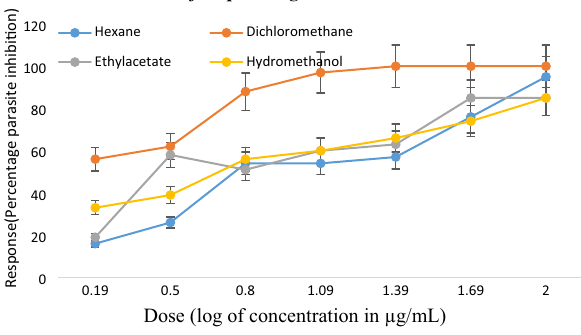
Fig. 3 Dose response curve showing percentage parasite growth inhibition after 48 h exposure to different doses of A. floribunda fractions using Mark III